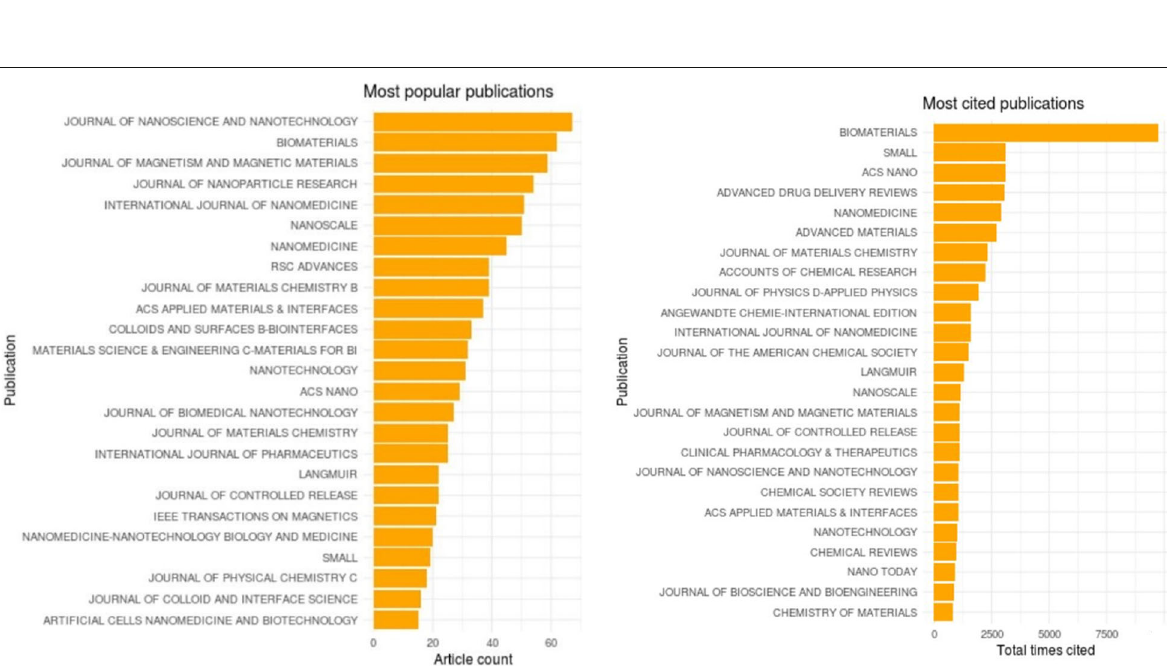
Fig. 4 Important publications with the number of articles in their dataset and their